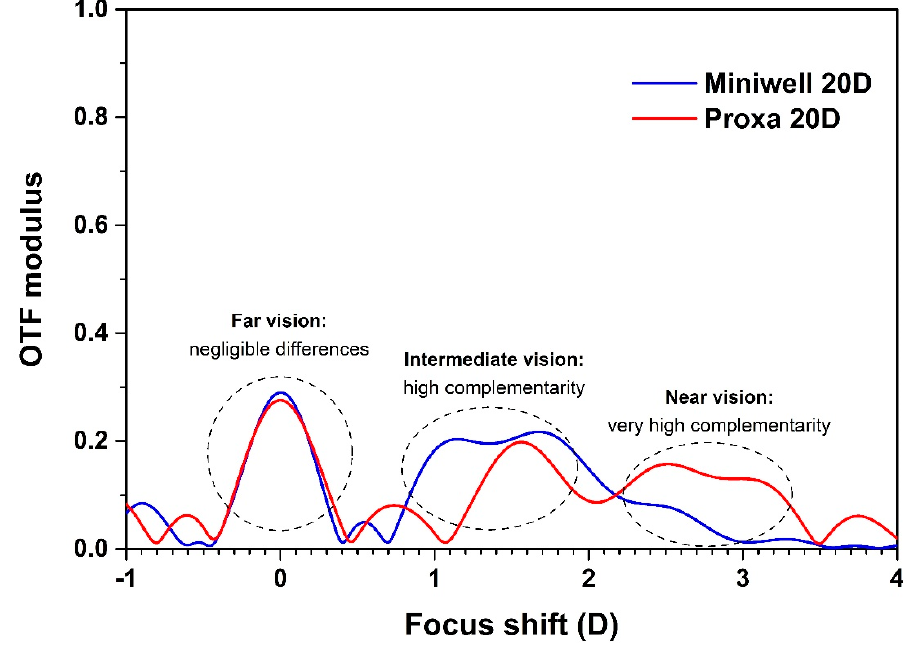
Figure 21. Theoretical Through-Focus Modulation Transfer Function (TF-MTF) curves of Mini WELL and Mini WELL PROXA with a 3 mm aperture and spatial frequency of 50 lp/mm. (Courtesy of SIFI SpA).